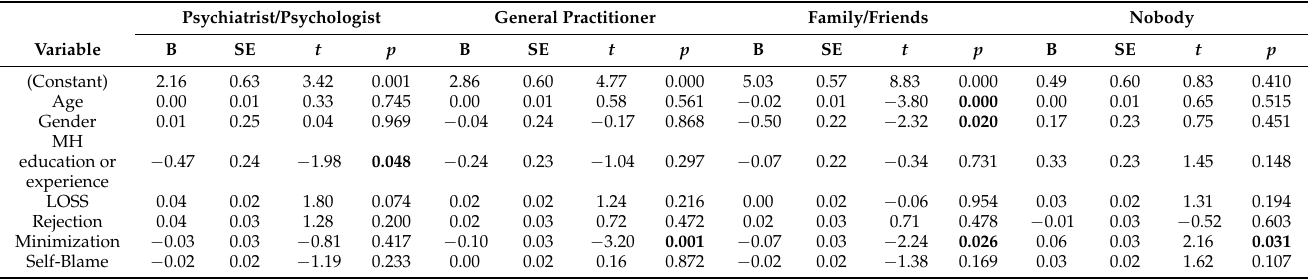
Table 5. Summary of hierarchical regression analyses for each source of help as the outcome